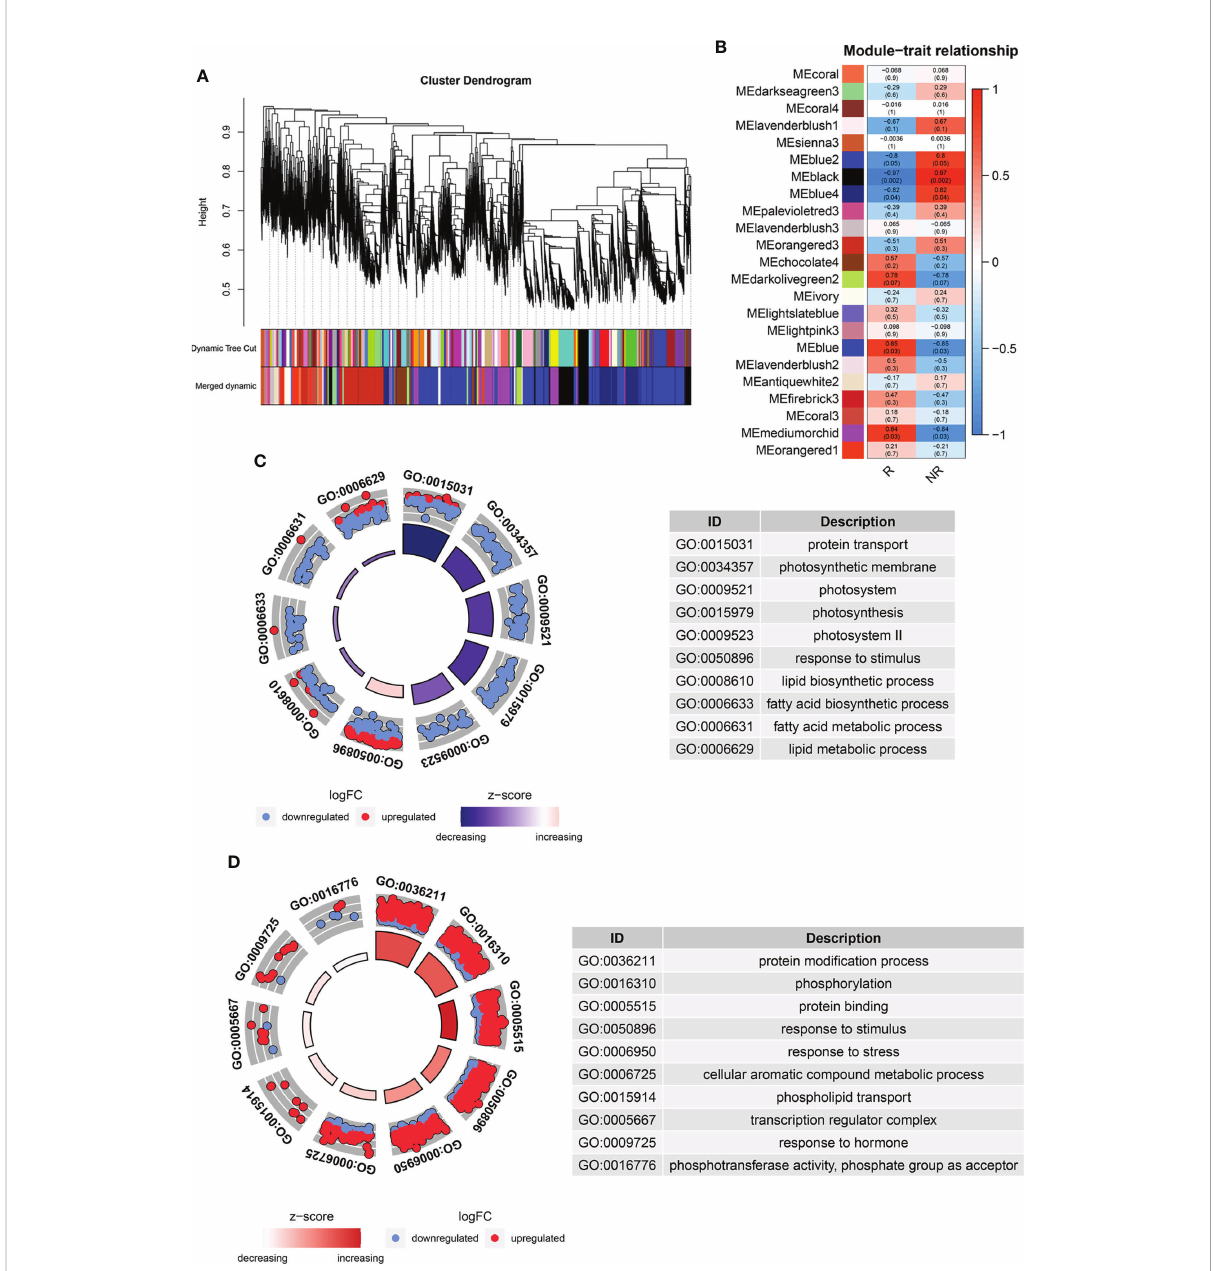
FIGURE 4 WGCNA analysis of DAMs and DEGs. (A) Dendrogram with co-expressed gene modules. (B) Module-trait correlations and P values. The left panel shows 23 modules in different colors, and the right panel from blue to red represents the correlation between modules. GO analysis of blue2, blue4 and black modules (C) , blue and mediumorchid modules (D)